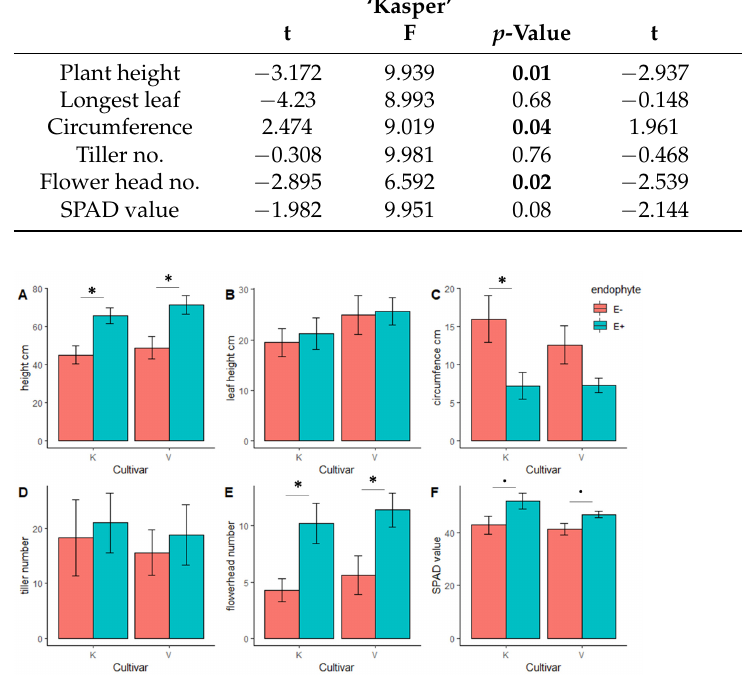
Table 4. The effect of Epichloë symbiosis on the plant parameters in the two meadow fescue cultivars was analyzed with a Student’s t -test. Significant p -values are highlighted in bold. N = 5–6. ‘Kasper’